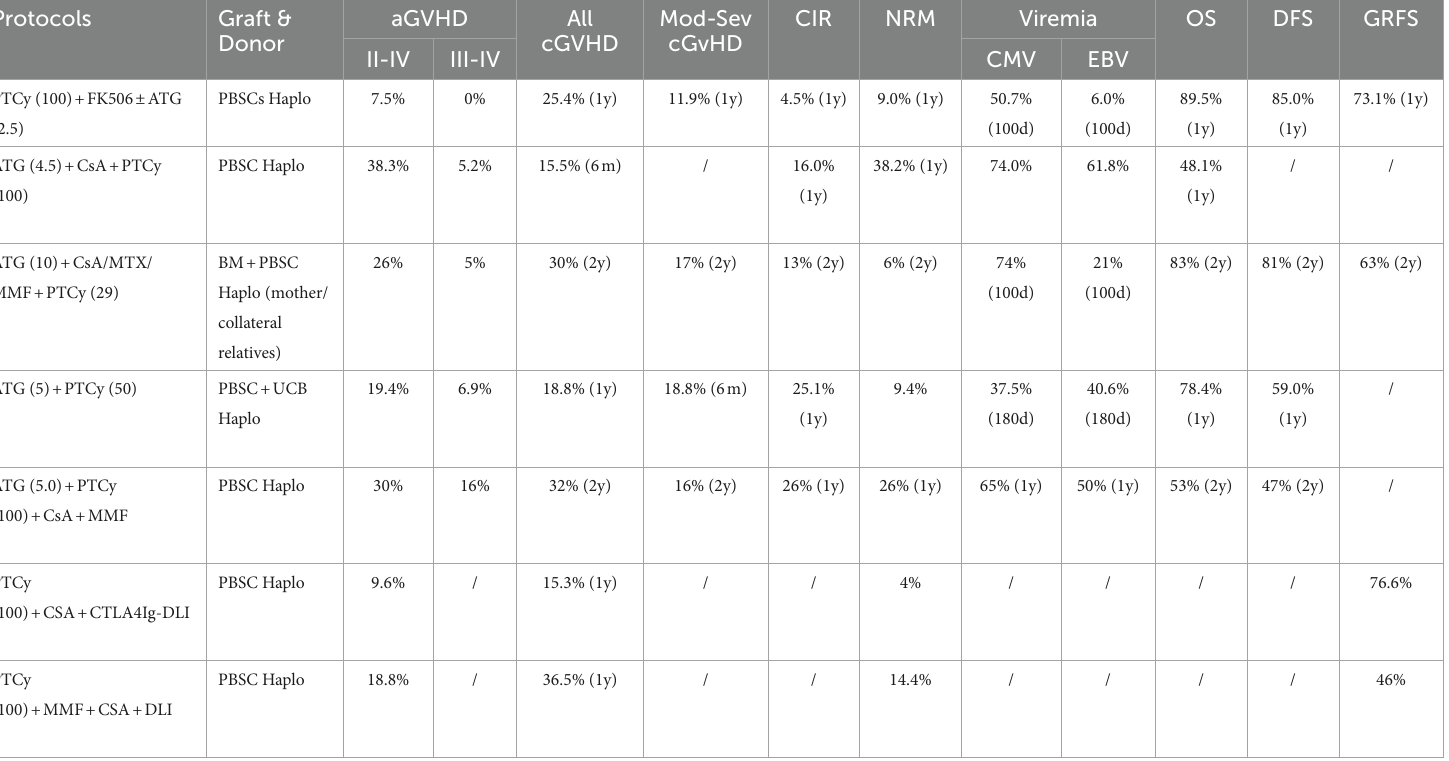
TABLE 4 GVHD prophylaxis protocols: ATG combined with PT-Cy. Group Patients’